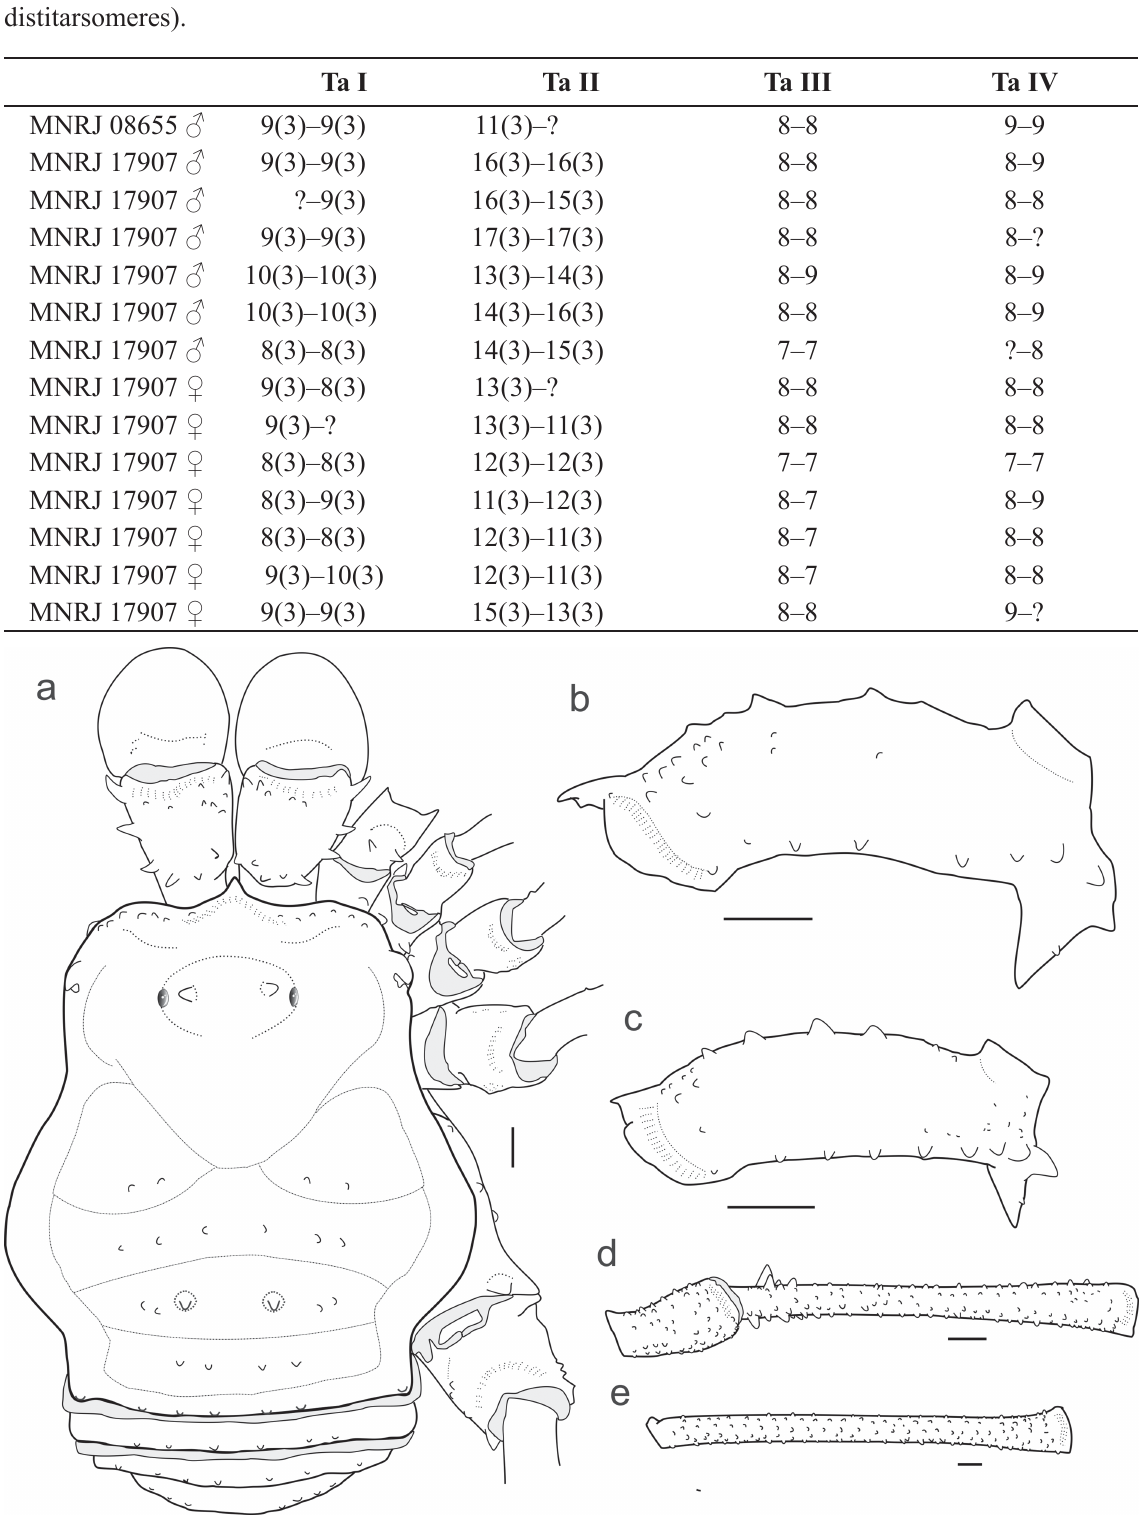
Fig. 11. Phalangodus gyes sp. nov. a–b , d–e . Holotype, ♂ (MNRJ 8655). c . Paratype, ♀ (MNRJ 17907). a . Habitus, dorsal view. b . Left pedipalp femur, ectal view. c . Left pedipalp, femur, ectal view. d–e . Right leg IV. d . Patella and tibia, dorsal view. e . Femur, dorsal view. Scale bars = 1 mm.